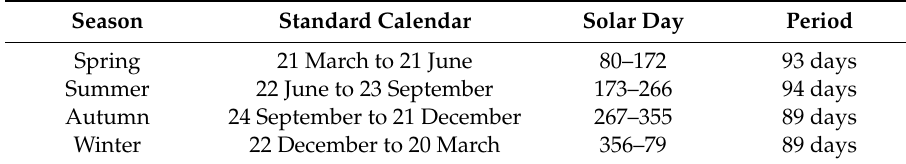
Table 3. Temporal Table 3. Temporal reference.